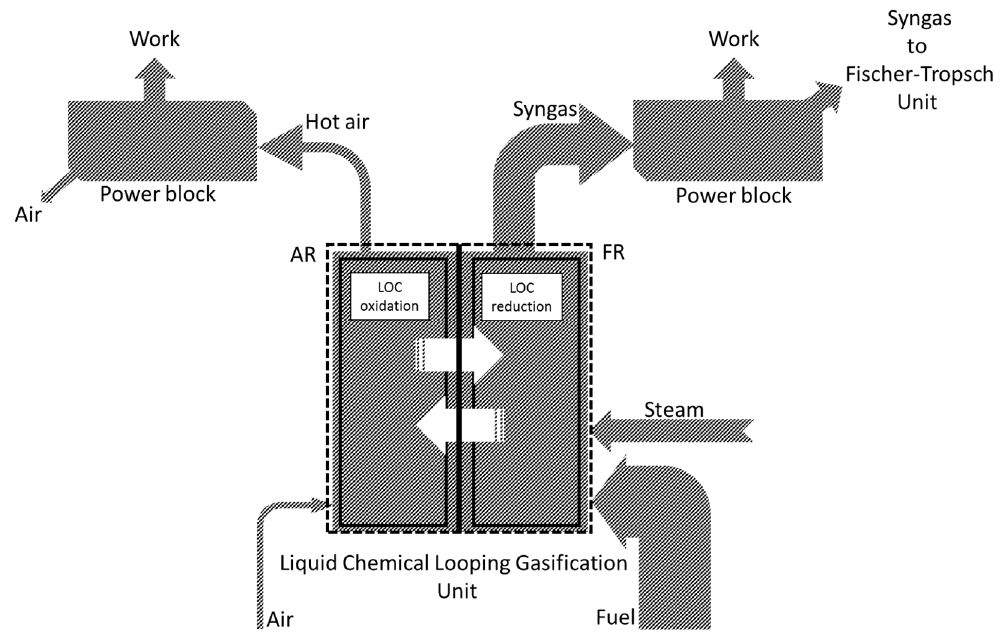
Figure 6. A schematic of the LCLG system connected to the power block. The liquid oxygen carrier (LOC) is circulated between reactors and the quality and exergy of syngas are controlled by the rate of circulation controls.